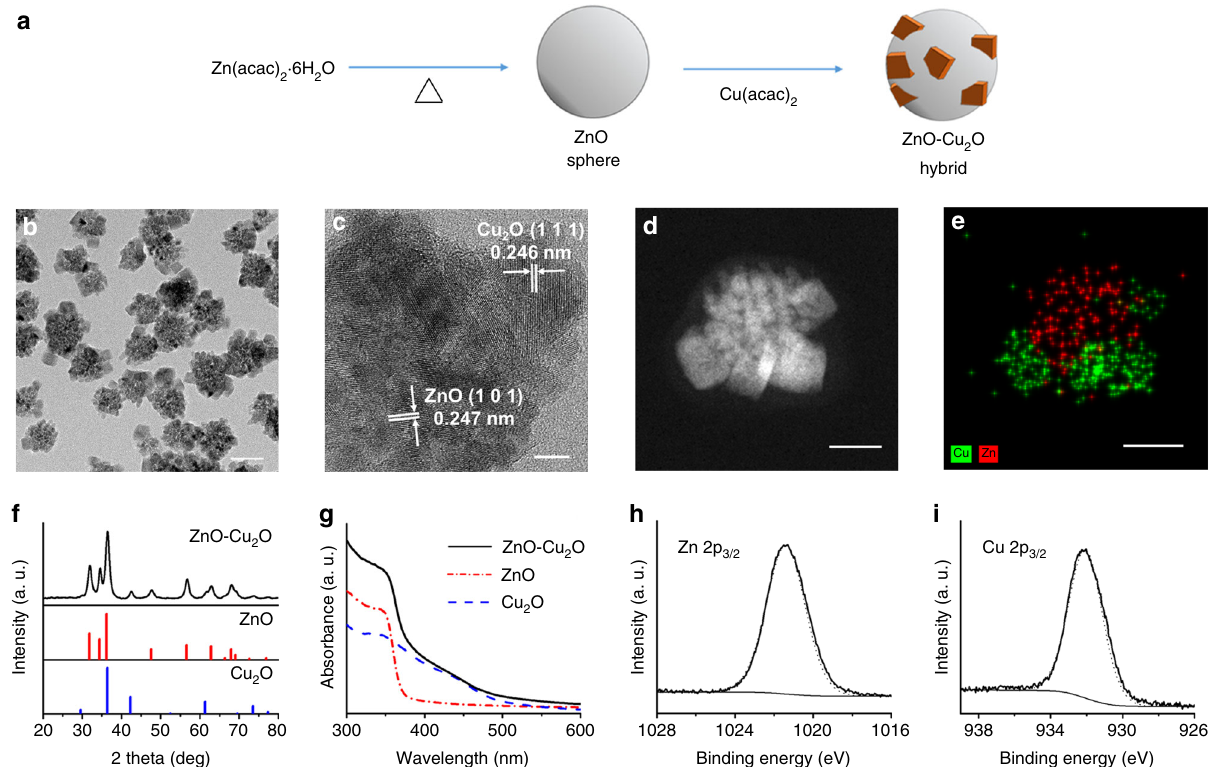
Fig. 1 Synthesis and characterization of the ZnO-Cu 2 O hybrid nanoparticles. a Synthesis of ZnO-Cu 2 O hybrid nanoparticles via a two-step in situ process. b TEM image of ZnO-Cu 2 O nanoparticles. c HRTEM and d STEM images, and e elemental mapping of an individual ZnO-Cu 2 O nanoparticle. The bars represent b 50, c 5, and d , e 20 nm. f XRD and g UV – Vis spectra of ZnO-Cu 2 O hybrid nanoparticles. XPS spectra of ZnO-Cu 2 O hybrid nanoparticles in the regions of h Zn 2p 3/2 and i Cu 2p